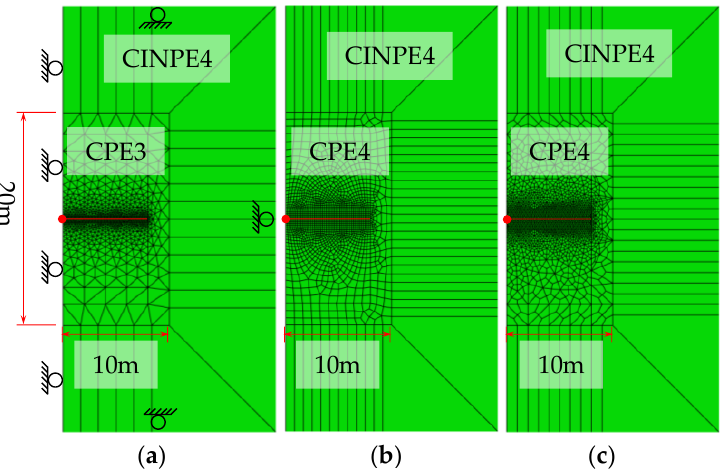
Figure 5. FEM model of the Khristianovic–Geertsma–de Klerk (KGD) problem. ( a ) Triangle mesh; ( b ) quadrangle mesh; ( c ) deformed quadrangle mesh.